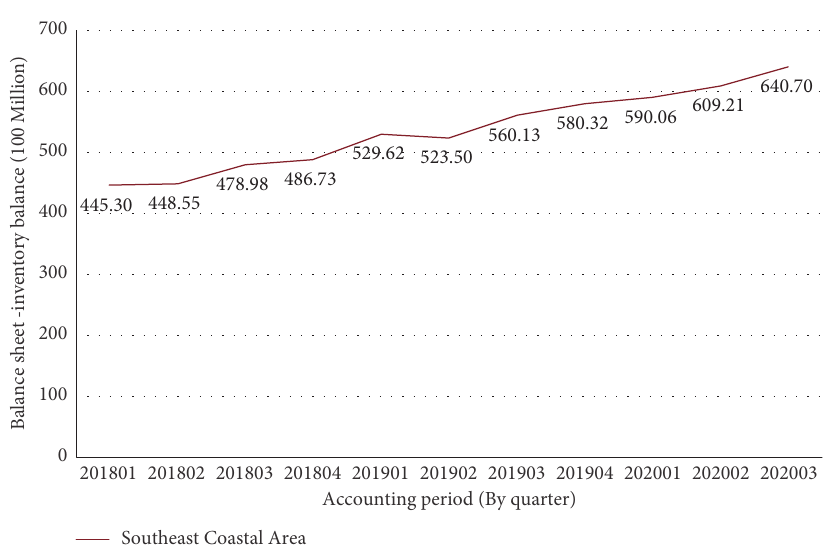
Figure 4: Changes in operating revenue of sample companies.